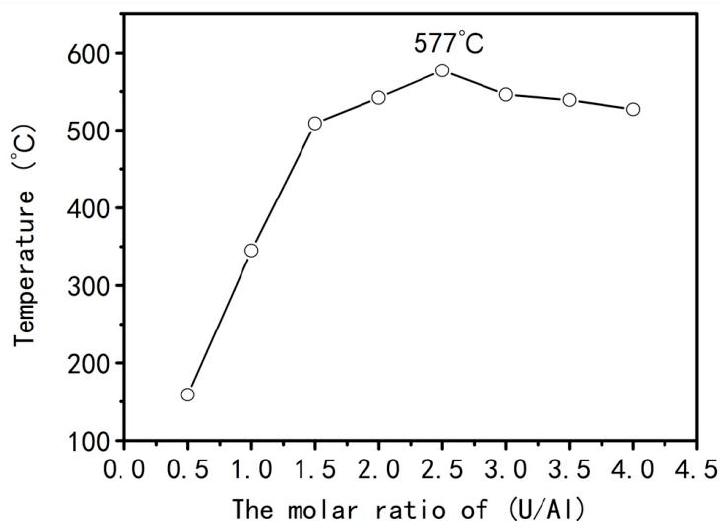
Figure 3. Combustion temperature of the solutions with various (U/Al).